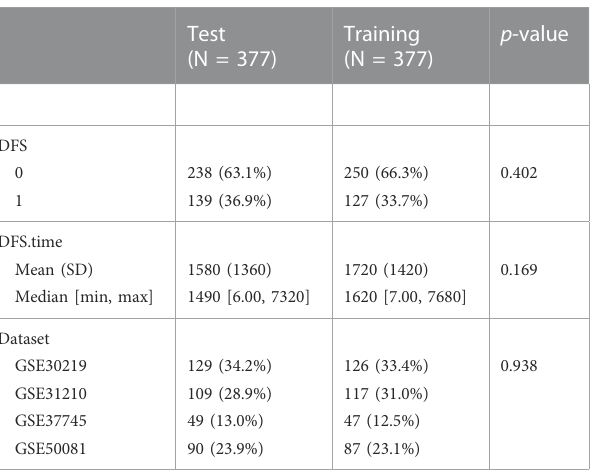
TABLE 1 Clinical information of the test and training